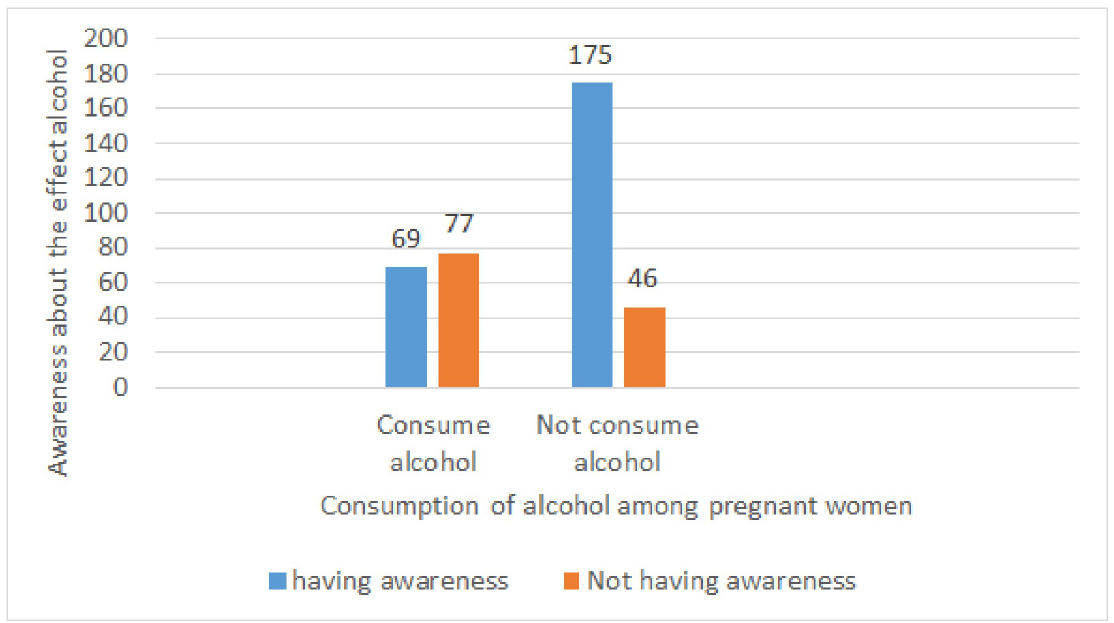
Fig 2. Magnitude of alcohol consumption among pregnant women respected to awareness about the harmful effect of alcohol on fetus in Kolfe Keranio sub city (n = 367), Addis Ababa, Ethiopia.